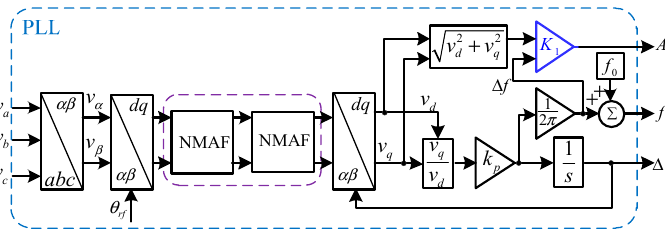
Figure 4. The detailed structure of the phase-locked loop (PLL).